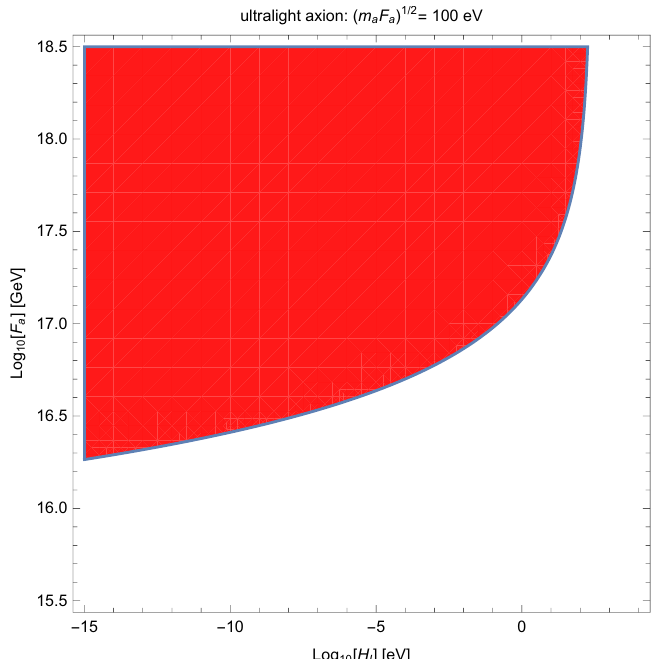
Figure 3 . Parameter space allowed for maximal-misalignment in a ultralight axion model. In the red region, the ultralight axion behaves as dark energy prior to matter domination. Therefore, this region leads to a cosmology very different from ours and is excluded. Outside these regions, the ultralight axion has a misalignment close to maximal and can compose the observed abundance of DM. See text for